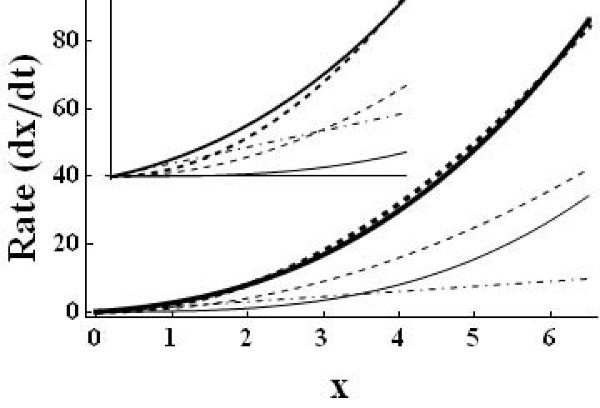
Rate curves [6] of system (2) for the parameters k1 = 8, k2 = 1, k3 = 1, k4 = 1.5. The thick solid line is the rate of the removal of reactant X (sum of the negative terms in ) and the thick dashed line the rate of production (positive term in ). The three crossings indicate the three steady states . The thin lines show the contributions of the three degradation terms separately: quadratic term k2x2 dashed, the effectively cubic term k3 xy solid, and the linear term k4 x dotdashed. The inset shows a zoomed version for x < 2.1.